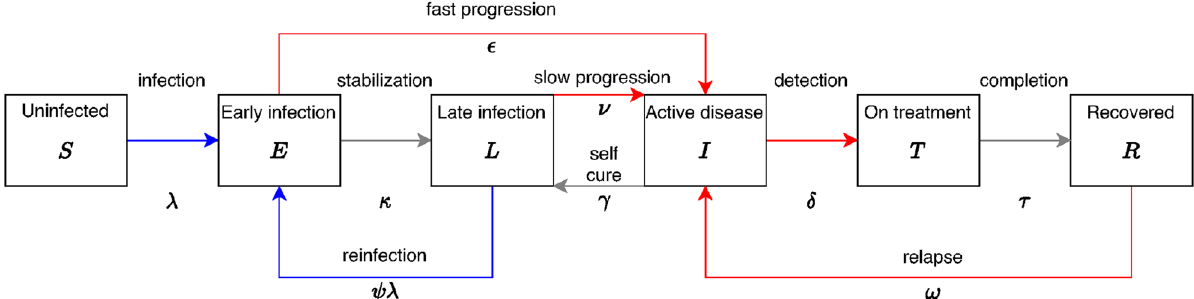
Figure 1. Model structure, duplicated for each sex. Red transitions are sex-dependent to represent different risks in disease progression and care access. Blue transitions represent infection, and are also sex-dependent due to assortative mixing. Not shown: death from all states at rate µ (and at an additional rate µ t from active TB disease); birth into Uninfected, at rate to keep population